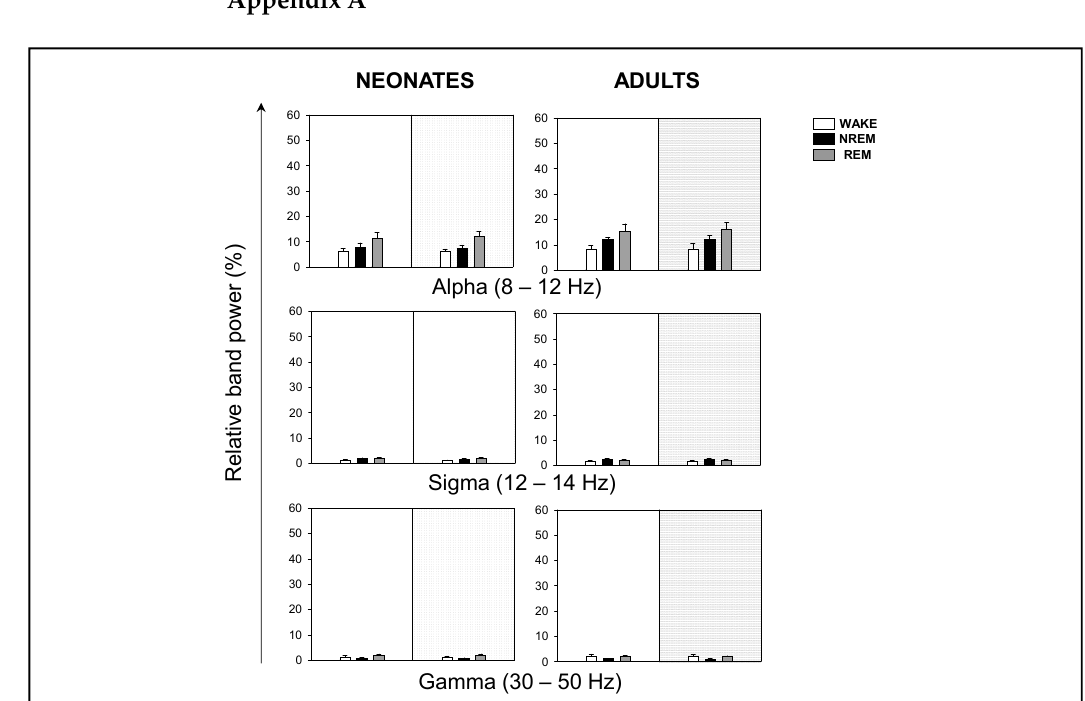
Figure A1. Relative band power of EEG during behavioral states in neonatal and adult mice. Relative band power of EEG in alpha ( α ), sigma ( σ ), and gamma ( γ ) during behavioral states. Data shown as mean ± SEM of either 18 or 27 recordings retrieved from 6 neonatal or 11 adult mice,